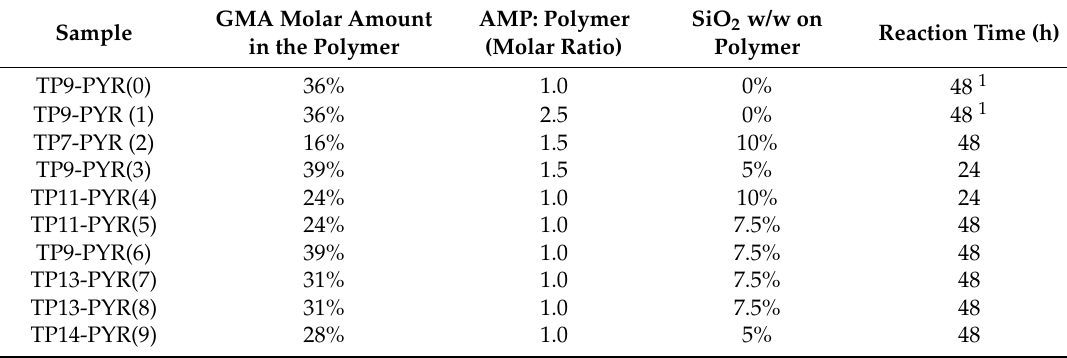
Table 3. AMP functionalization reaction carried out in DMA